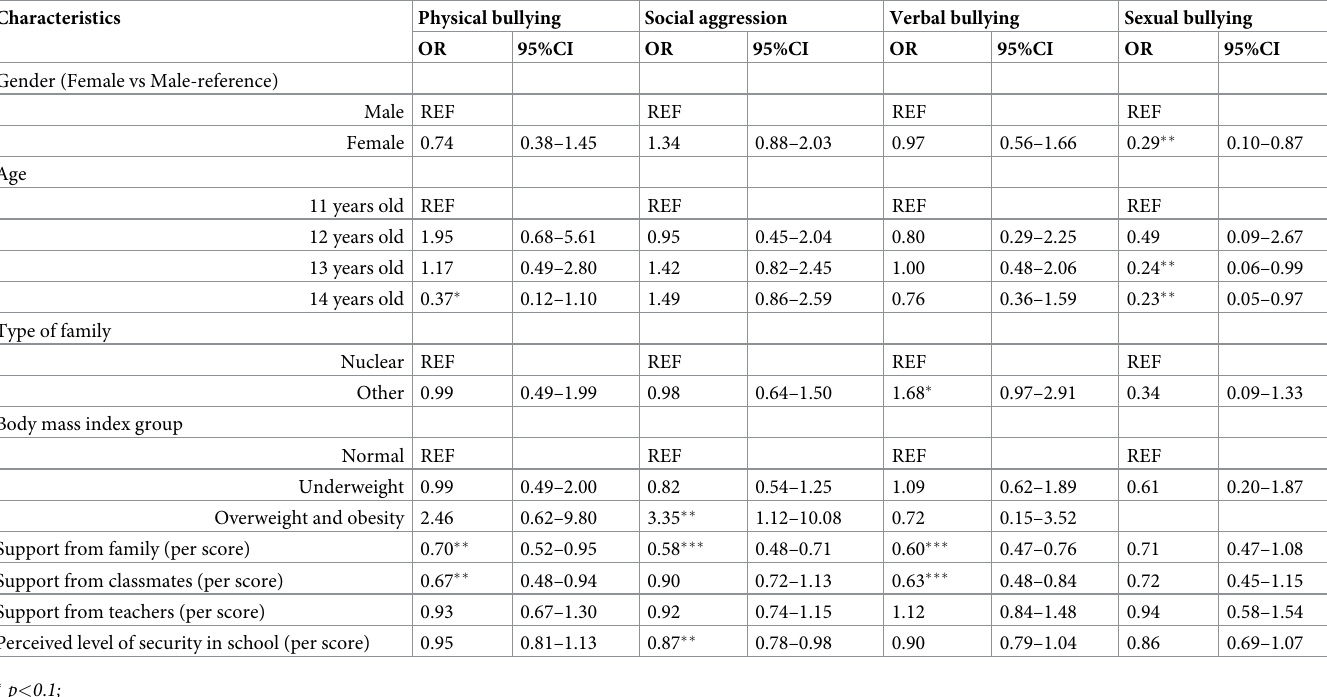
Table 4. Associated factors with bullying